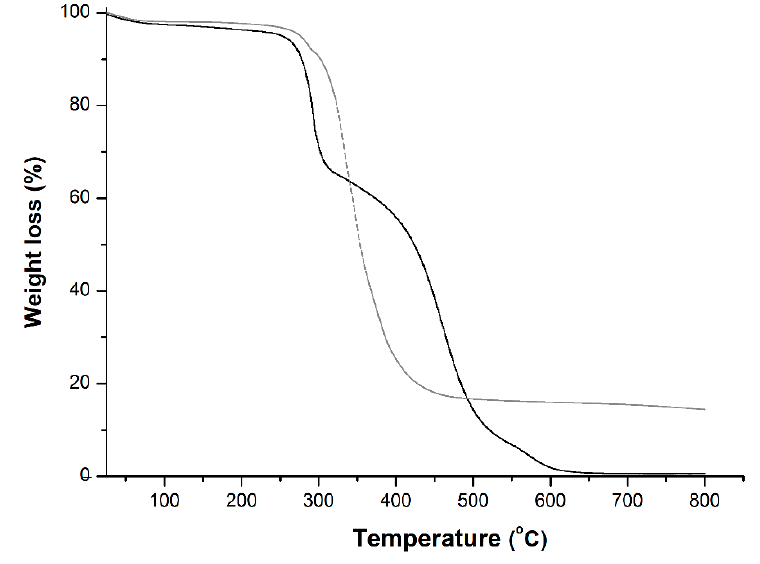
Figure 1. TGA traces of PUR1.BF4 under air (solid line) and inert atmosphere (dash line).